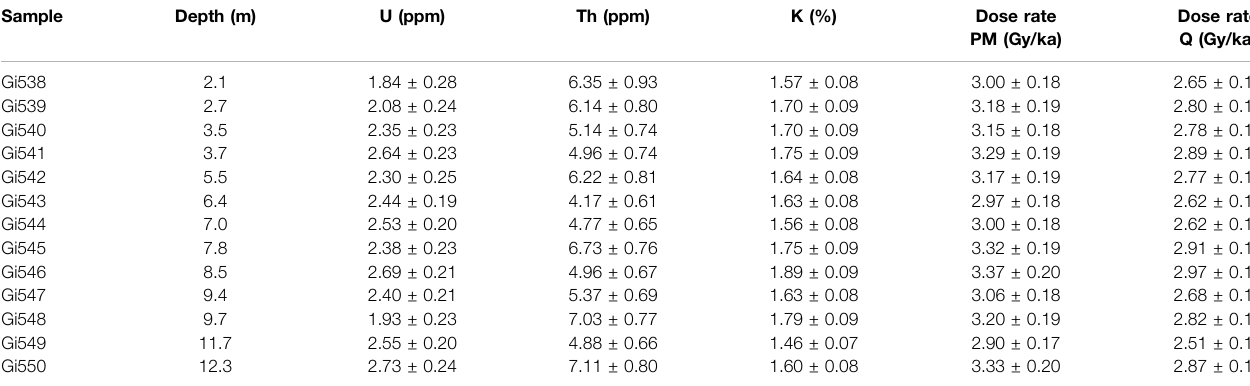
TABLE 5 | Radionuclide concentrations and resulting dose rates based on Durcan et al. (2015) for the quartz and polymineral fi ne grain fraction. Sample Depth (m) U (ppm) Th (ppm) K (%) Dose rate